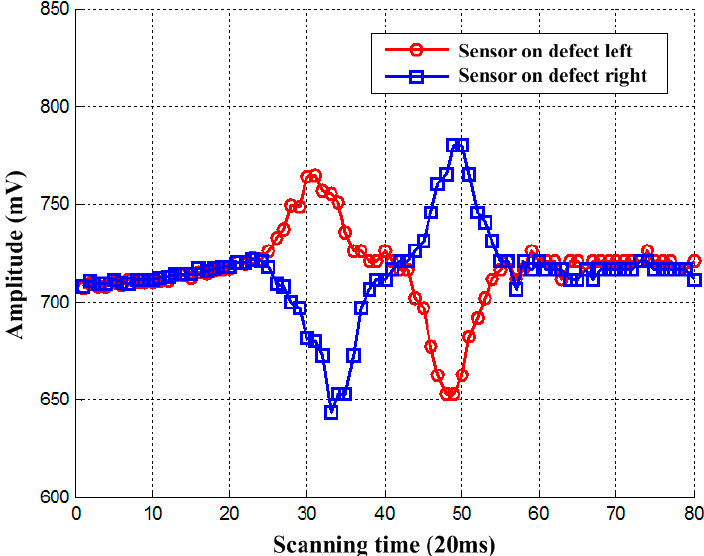
Figure 5. Curves of the A-scan’s peak on the defect’s two sides in the direction of the current.